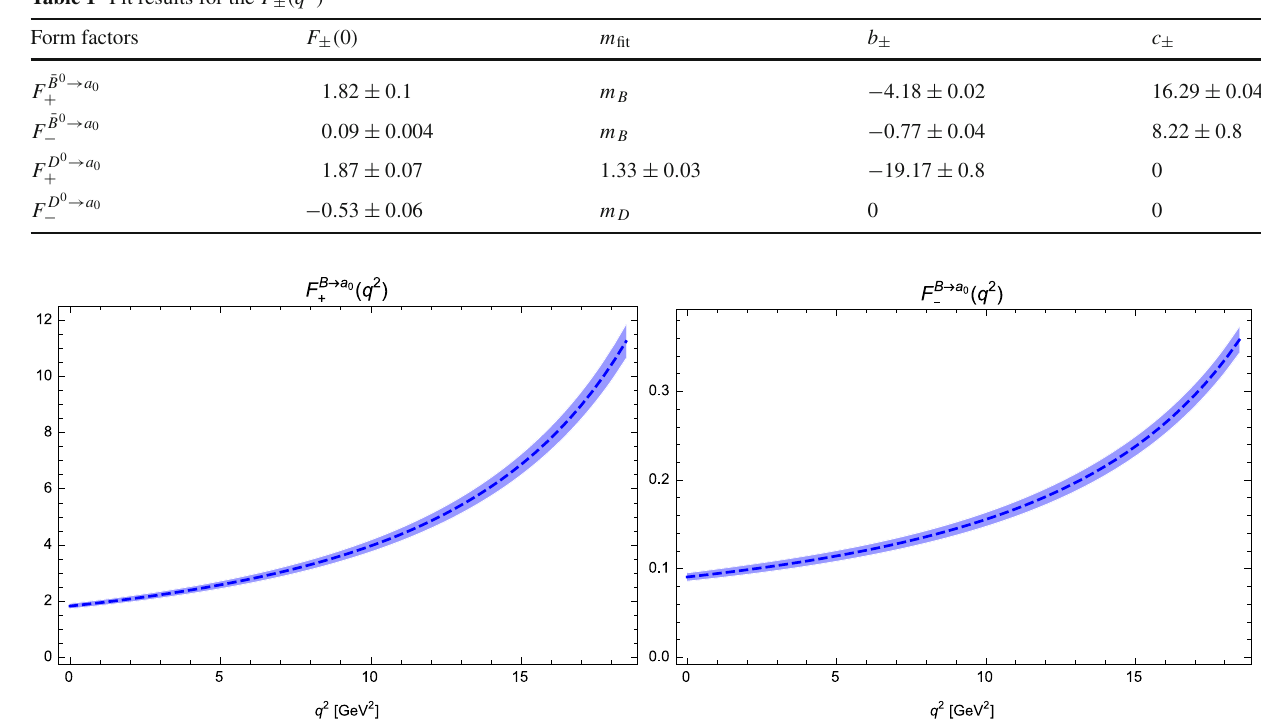
Table 1 Fit results for the F ± ( q 2 )